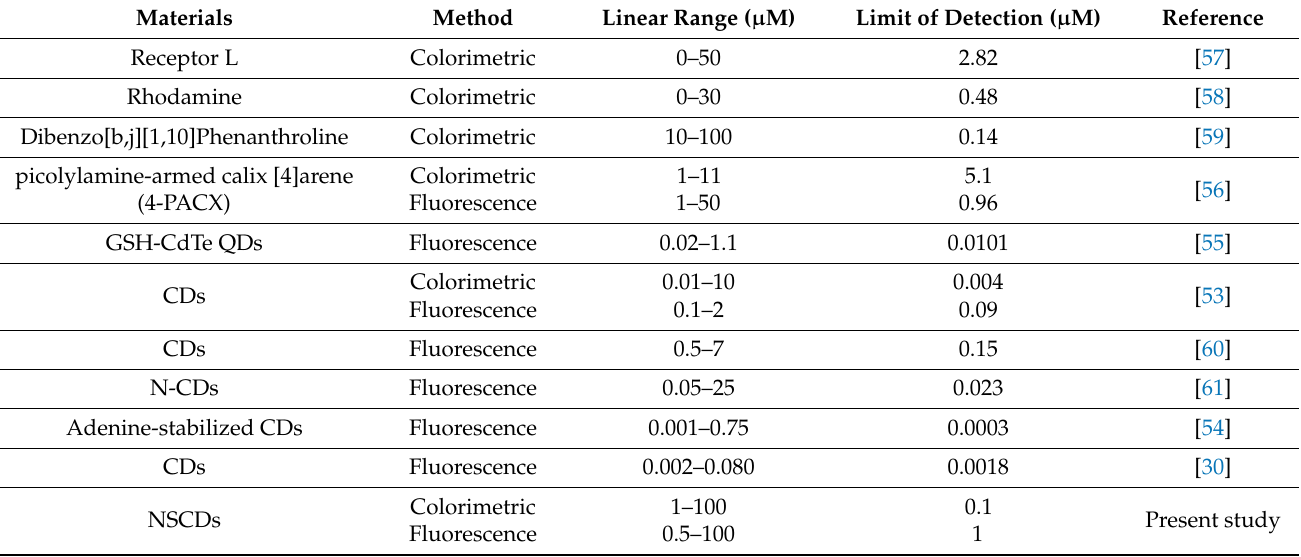
Table 1. Comparison of the performances of various optical techniques and nanomaterials for